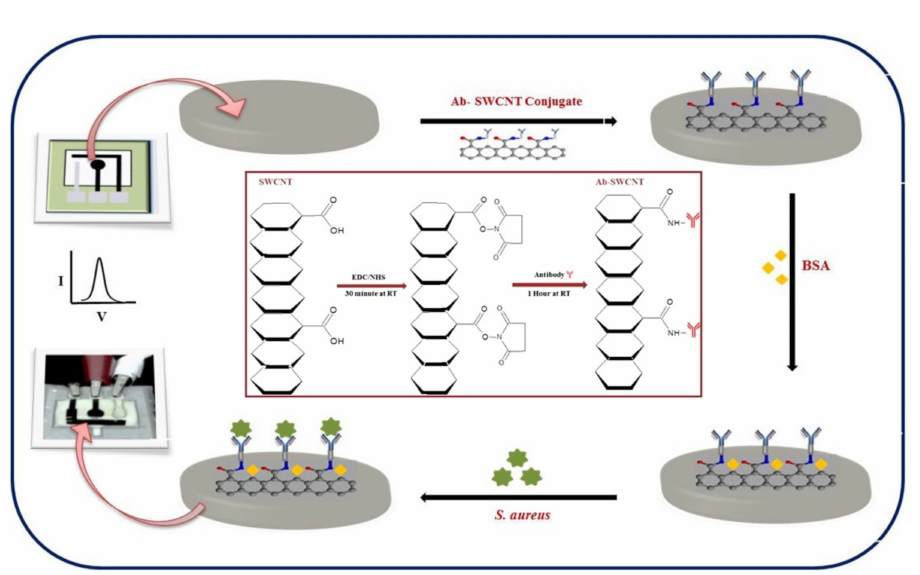
Figure 8. Scheme of the development of an antibody-SWCNT bioconjugate paper-based electrochem- ical immunosensor. Adapted with permission from [107] Copyright 2017,